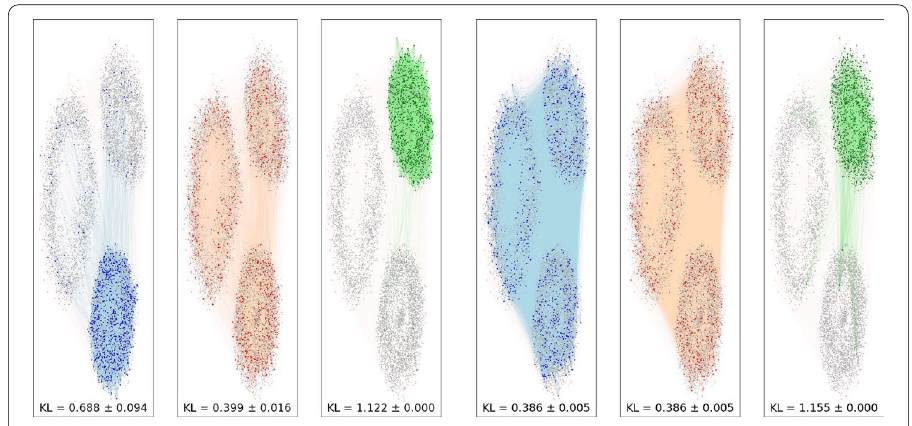
Fig. 3 Community structure and sampling. We show an example of sampling two synthetic SBM networks one (left) assortative and one (right) disassortative. Sampled nodes and edges are colored in blue for TCEC (left), red for uniform random walk (center) and green for snowball expansion sampling (right). The KL-divergence averages and standard deviations are computed over 10 different rounds of sampling 10% of all the